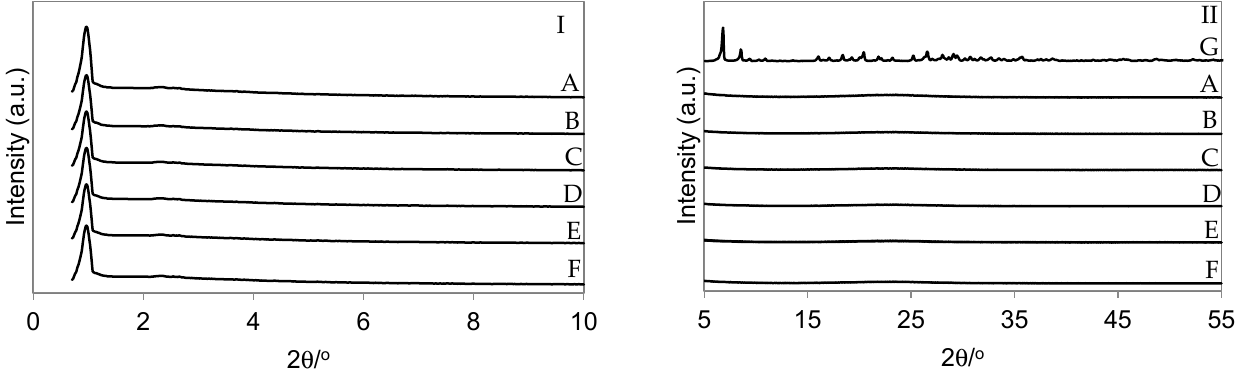
Figure 3. X-ray diffractograms of the catalysts. ( I ) 2 θ region of 0.7 ◦ to 10.0 ◦ ; ( II ) 2 θ region of 5.0 ◦ to 55.0 ◦ ; (line A) KIT-6; (line B) PW1-K-6; (line C) PW2-K-6; (line D) PW3-K-6; (line E) PW4-K-6; (line F) PW5-K-6; (line G) PW.